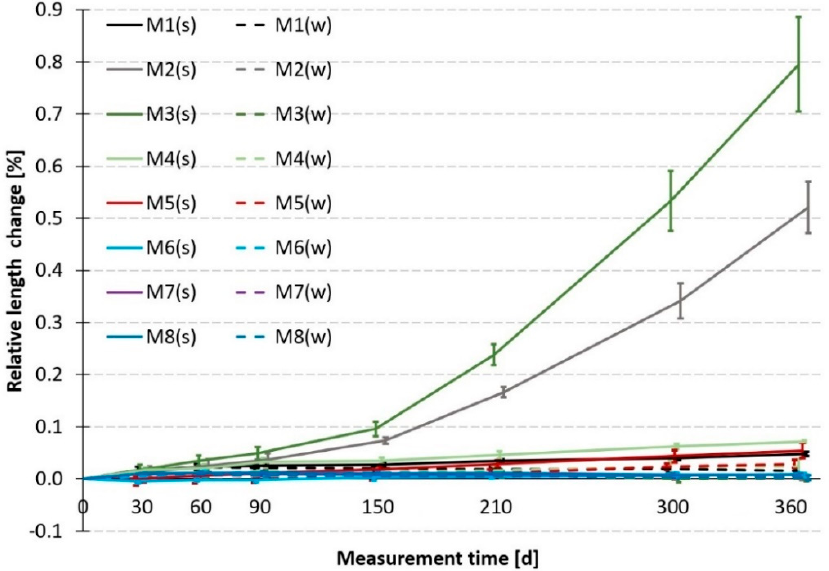
Figure 12. Dependence of relative length changes on the immersion time of the samples in the sulfate (s) and water (w) bath.